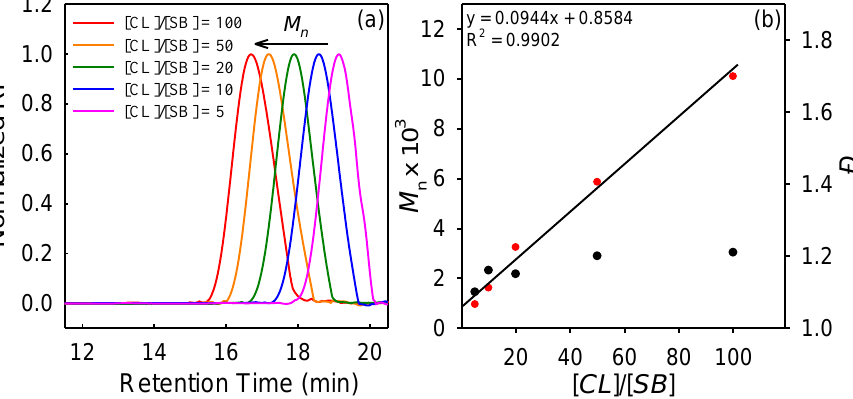
Figure 2. ( a ) GPC curves of the PCLs and ( b ) plot of M n and Ð versus [ CL ]/[ SB ] obtained using various amounts of SB initiator. Conditions: DMC-EAA = 10 mg ([ Zn ] 0 = 30 mM), [ CL ] 0 = 9 M, T p = 160 °C.